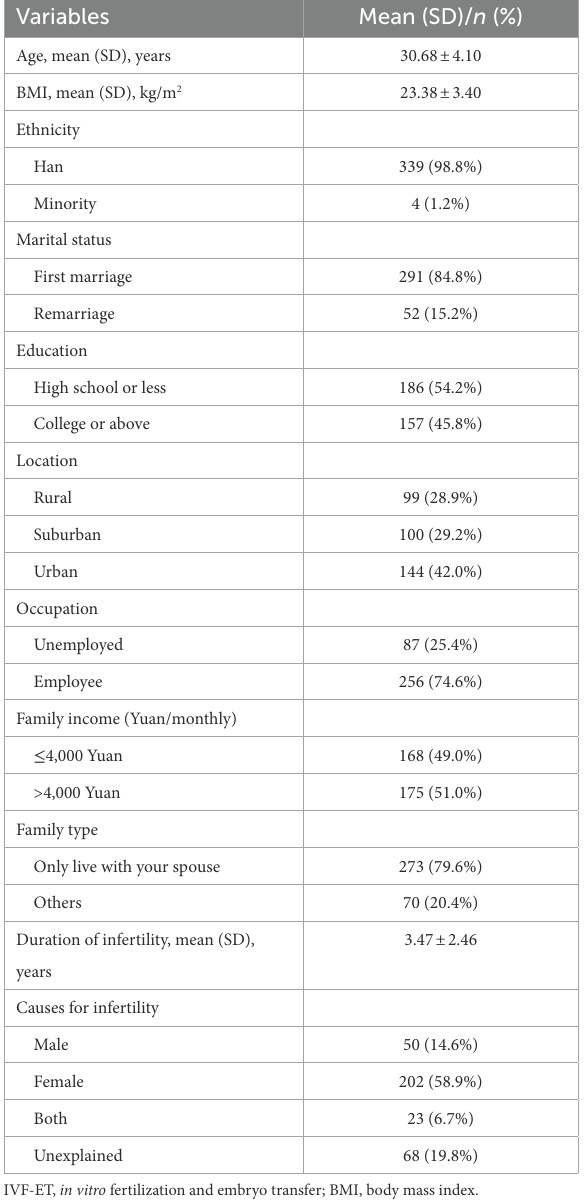
TABLE 1 Baseline sociodemographic data, and clinical characteristics of women undergoing IVF-ET ( n =